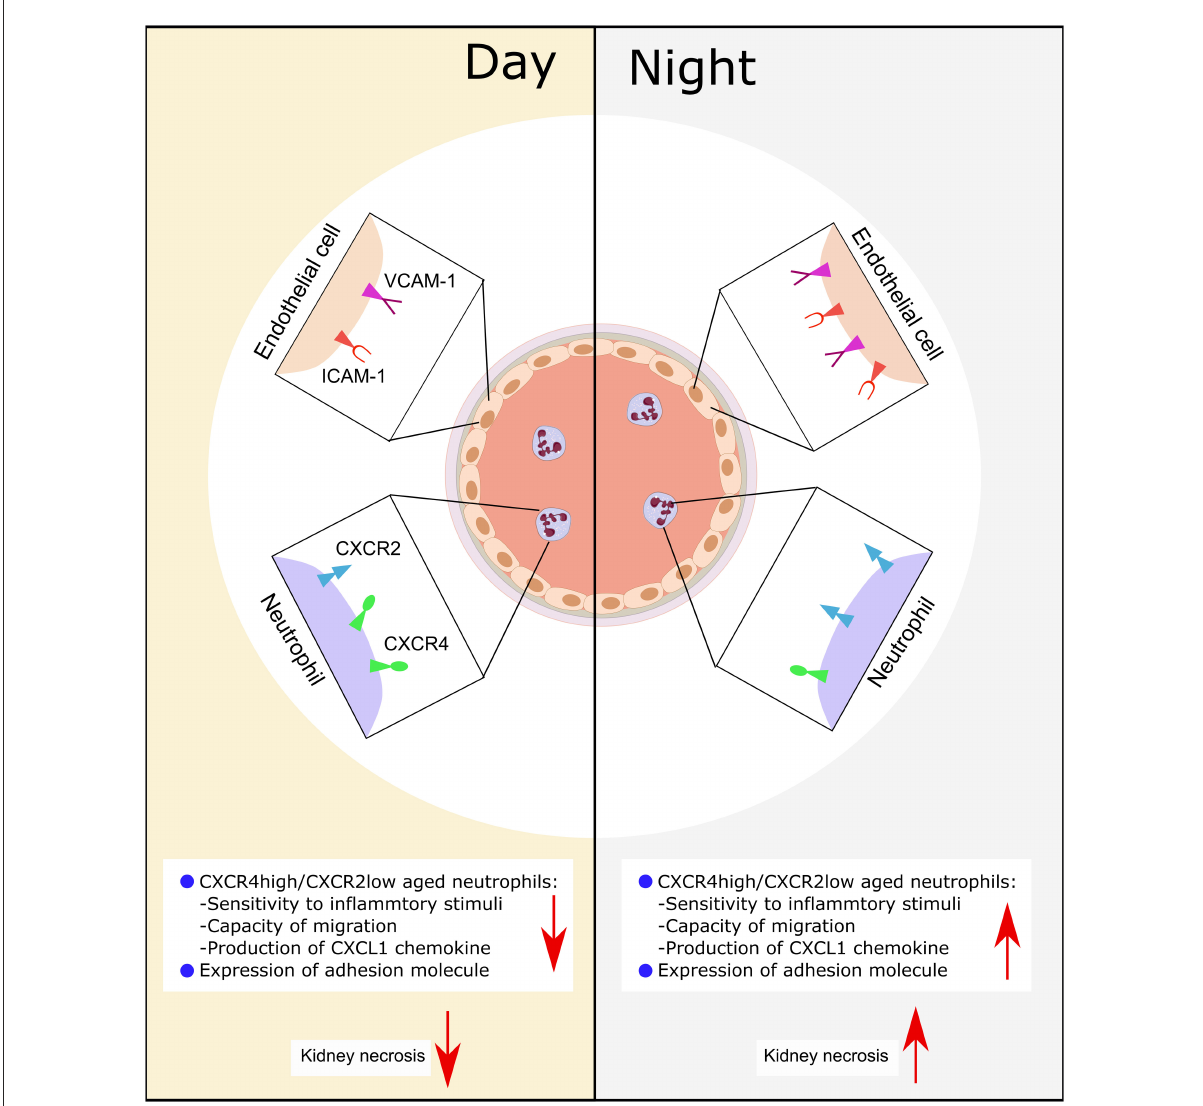
FIGURE6 Schematic illustration of the putative mechanism of circadian rhythm-related kidney injury. During the day, the expression of adhesion molecule ( Icam -1, Vcam -1) on endothelial is lower than the night, the release of chemokine (CXCL1) from immune cells is less than the night, the expression of CXCR2 is lower, while the CXCR4 is high. Consequently, this leads to more tissue necrosis during the